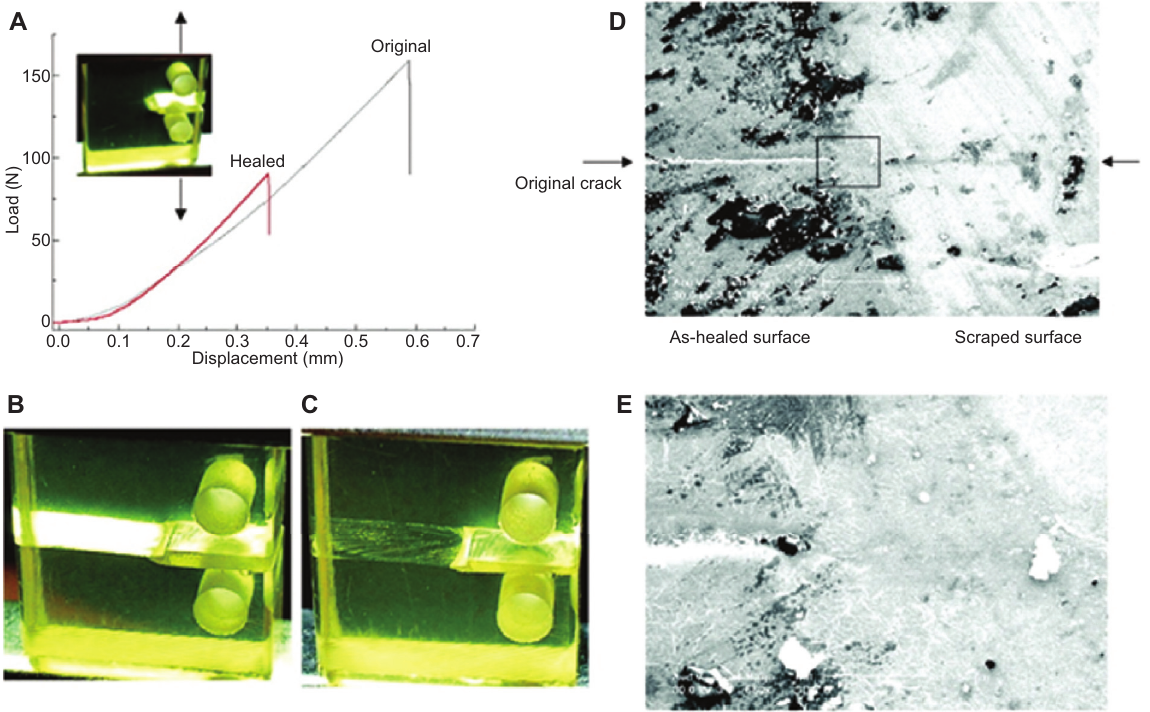
Figure 11 Self-healing studies of the polymer. (A) Fracture toughness testing of compact tension test specimens. (B and C) Images of a broken and healed specimen before and after thermal treatment. (D and E) SEM images of a healed sample surface: The left side is the as- healed surface and its enlarged image of the boxed area (reprinted with permission from [42]. Copyright 2002, The American Association for the Advancement of